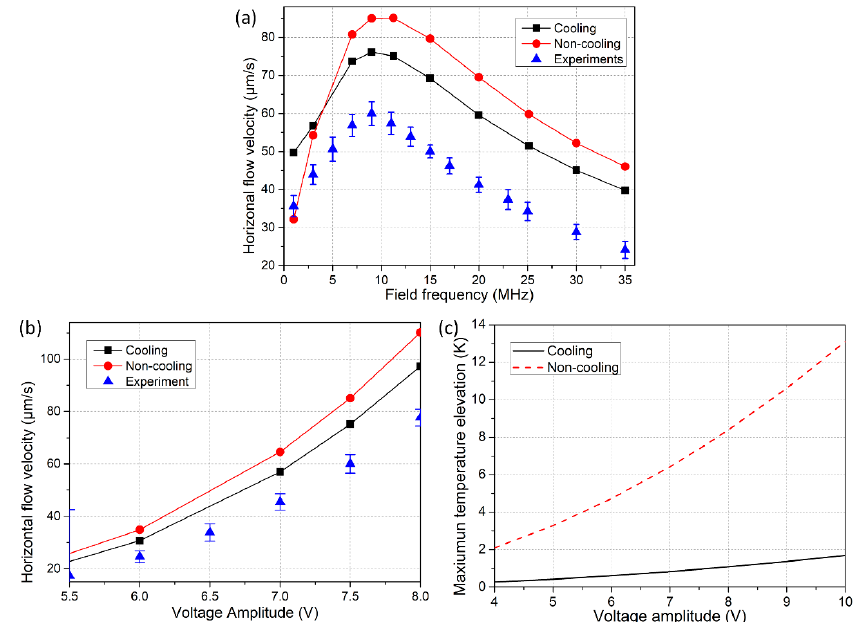
Figure 6. Comparison of electrothermal flow velocity and temperature elevation between theory and experiment for both cooling and non-cooling cases. ( a ) Frequency-dependence of maximum horizontal flow velocity; ( b ) Voltage-dependence of maximum horizontal flow velocity; ( c ) Voltage-dependence of maximum temperature rise within the medium bulk.